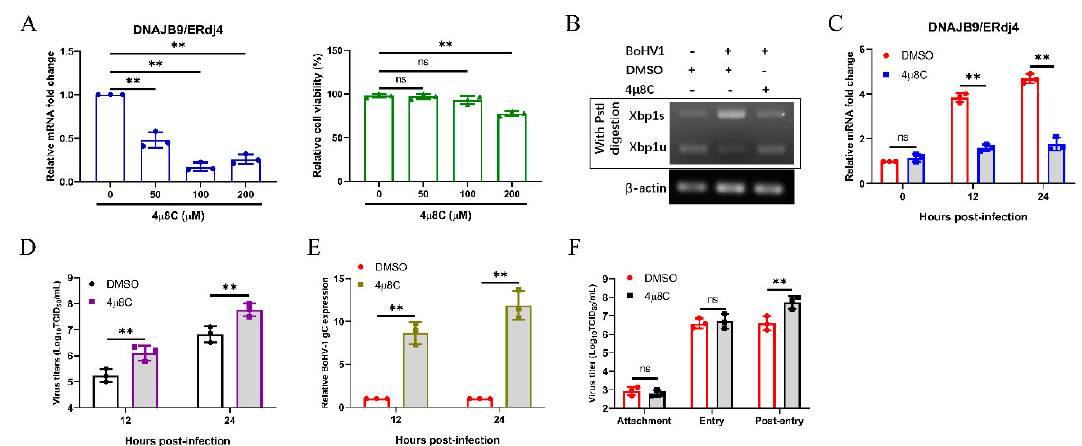
Figure 6. BoHV-1 replication is enhanced by inhibiting IRE1 RNase activity in MDBK cells. ( A ) The efficiency of 4 μ 8C in inhibiting the IRE1 RNase activity was evaluated by detecting the ERdj4 mRNA levels in MDBK cells. The cytotoxicity of 4 μ 8C was measured using a CCK-8 assay. ( B – E ) MDBK cells were treated with 4 μ 8C (100 μ M) or DMSO, followed by infection with BoHV-1 (0.1 MOI). ( B ) MDBK cells were harvested at 24 hpi and subjected to XBP1 splicing assay. ( C ) MDBK cells were harvested at 0, 12, and 24 hpi, and qPCR analysis of ERdj4 mRNA levels. ( D ) MDBK cells were harvested at 12 and 24 hpi and viral titers of BoHV-1 were determined. ( E ) qPCR analysis of the BoHV-1 gC expression in MDBK cells at 12 and 24 hpi. ( F ) Effect of IRE1 RNase activity inhibition on BoHV-1 replication stages. The mean ± SD of data from three independent experiments are shown; * p < 0.05, ** p < 0.01.